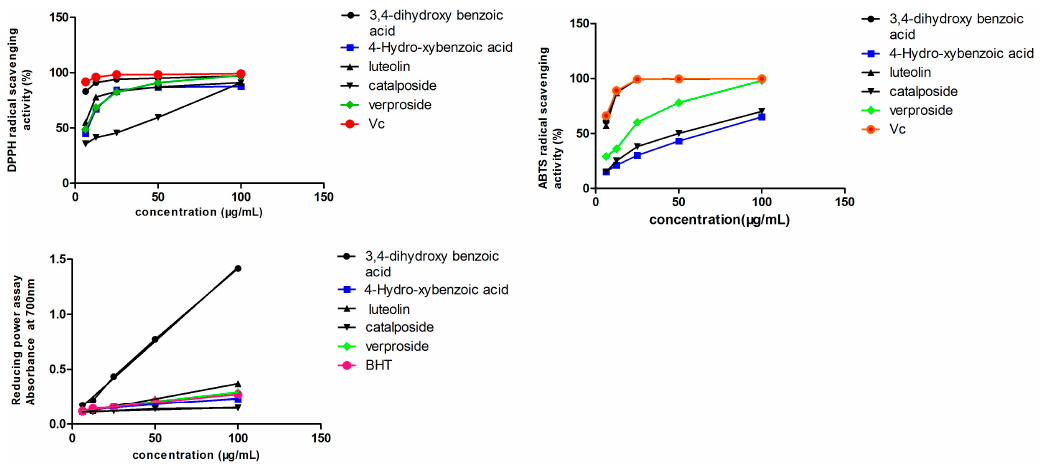
Figure 4. Determination of the antioxidant activity of the five compounds: ( A ) DPPH, ( B ) ABTS and ( C ) reducing power assay. Vc, vitamin C.